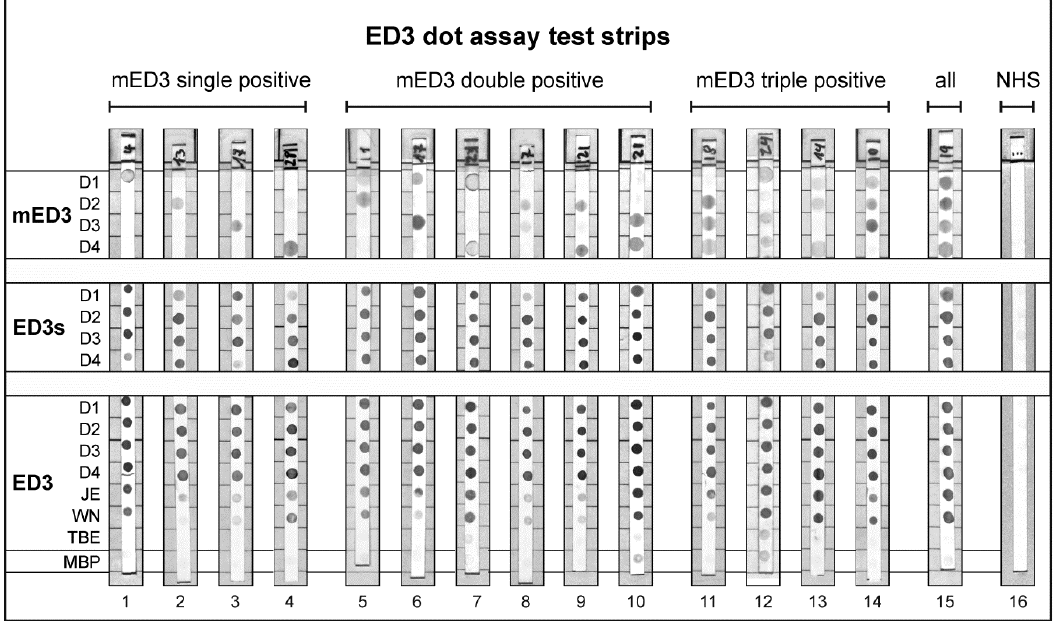
Figure 4. ED3 dot assay test strips. Exemplarily shown are test strips results for all combinations of mED3 positivity. Sera used for the assay are described in Table 3. NHS, normal human serum negative for DENV and JEV antibodies. Table 3. Characteristics of patient sera used for the development of test strips as shown in Figure 4.